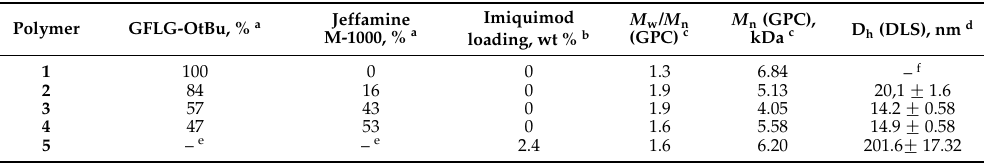
Table 1. Structural data for polymers 1 – 5 .